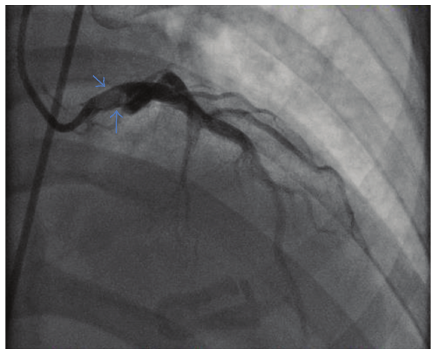
Figure 1: Angiogram in RAO & CRANIAL view demonstrating large proximal thrombus attached to the superior and proximal walls of the left main coronary artery, as indicated by